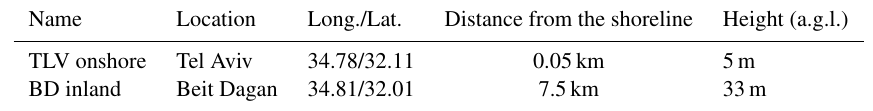
Table 2. Ceilometer CL31 location.